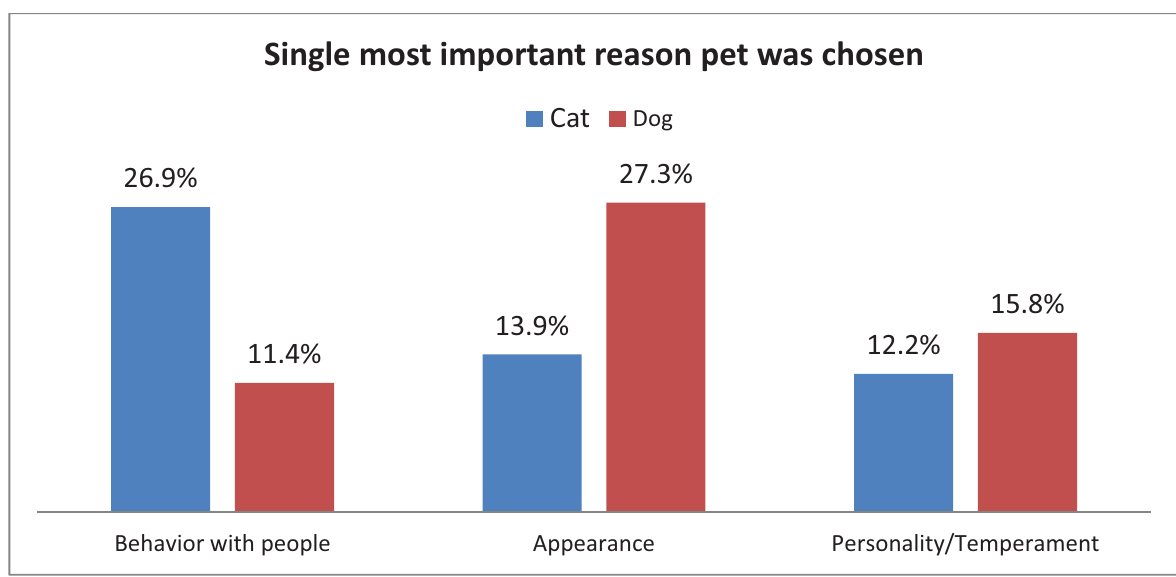
adult dog or cat.